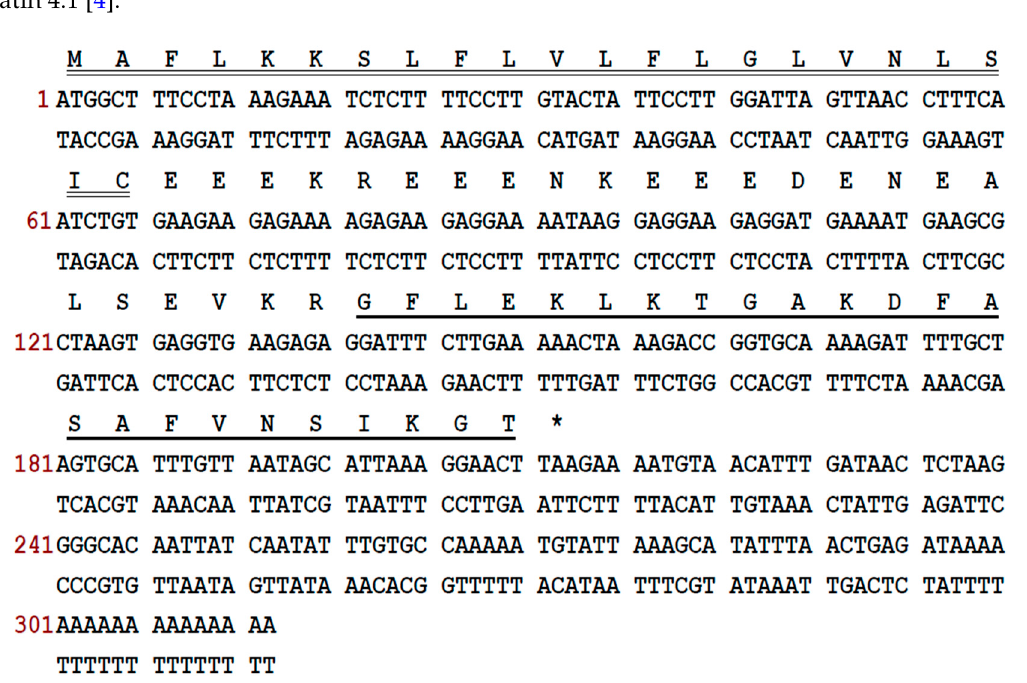
Figure 1. Nucleotide sequence of the cDNA cloned from L. infrafrenata skin secretion and its predicted peptide sequence. The putative signal peptide (double-underlined), mature peptide (single-underlined) and stop codon (asterisk) are indicated.